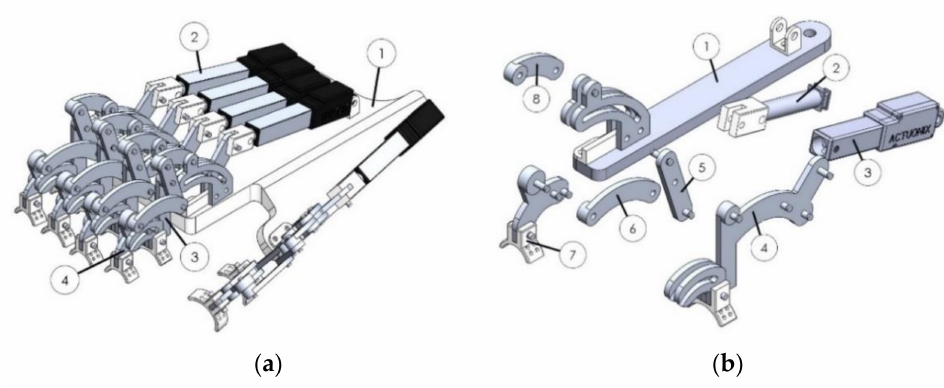
Figure 2. ( a ) Proposed exoskeleton (general view) and ( b ) exploded view of the single DOF.